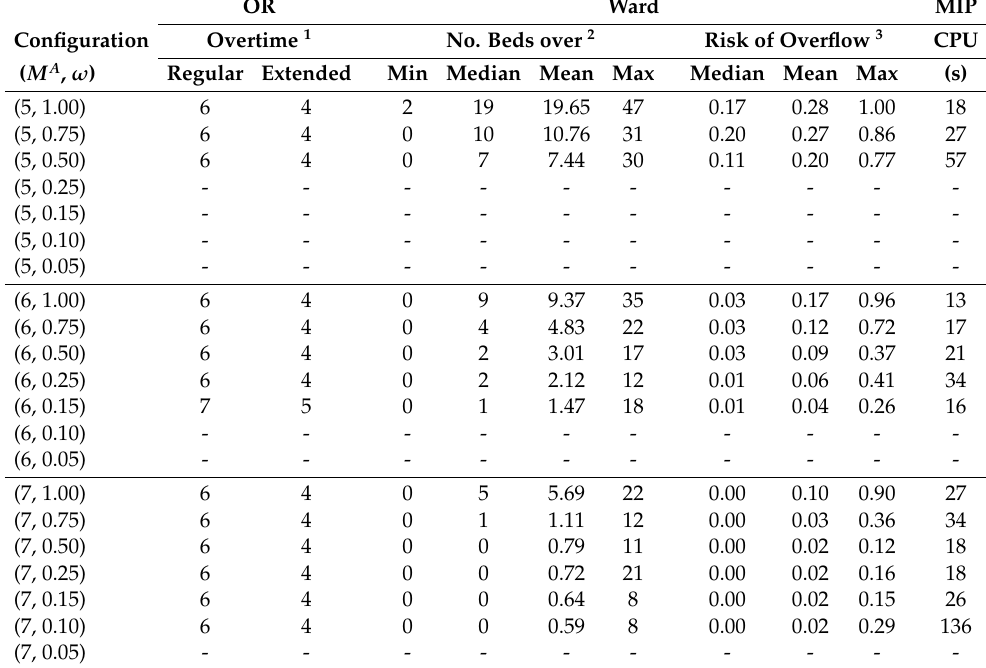
Table 3. Quality of solutions and computational requirements for different configurations of ( M A , ω ) for the robust ward optimization (RWO). Here, M A denotes the maximum number of staffed ward beds and ω denotes the limit on the likelihood that a ward combination exceeds the number of staffed ward